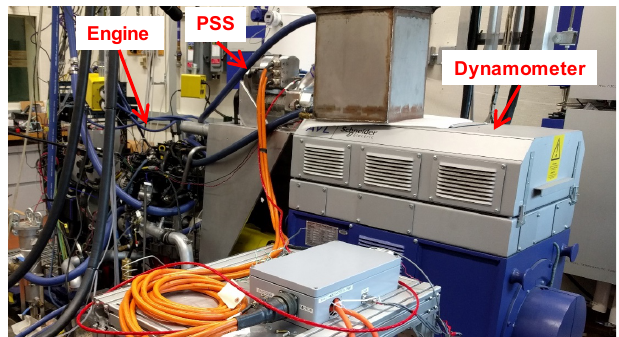
Figure 9. Engine-dynamometer experimental testbed.